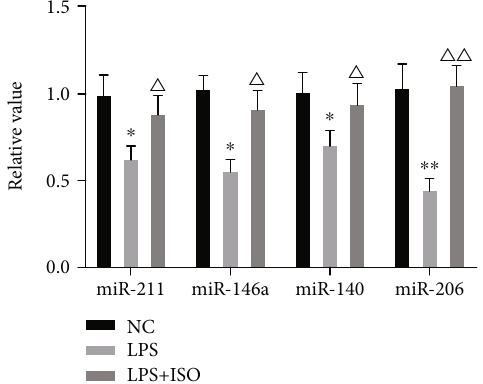
Figure 2: ISO upregulated the expression of miR-206 in NHAs cells. ∗ p < 0 : 05 , ∗∗ p < 0 : 01 vs. the NC group; Δ p < 0 : 05 , ΔΔ p < 0 : 01 vs. the LPS